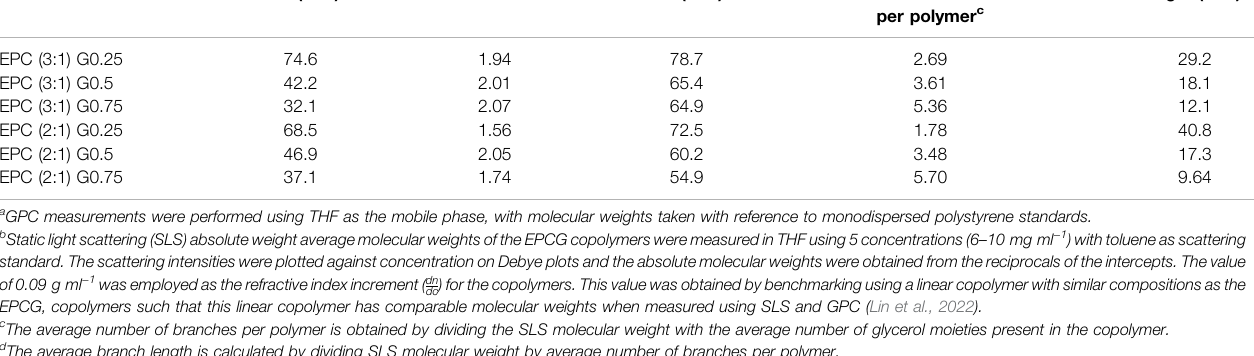
TABLE 1 | Summary of EPCG copolymers properties. Sample